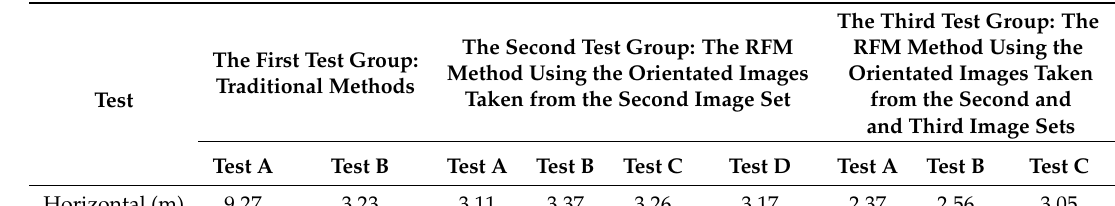
Table 5. Accuracies for TH1-Scene01, TH1-Scene02 and TH1-Scene03 with traditional methods and the RFM